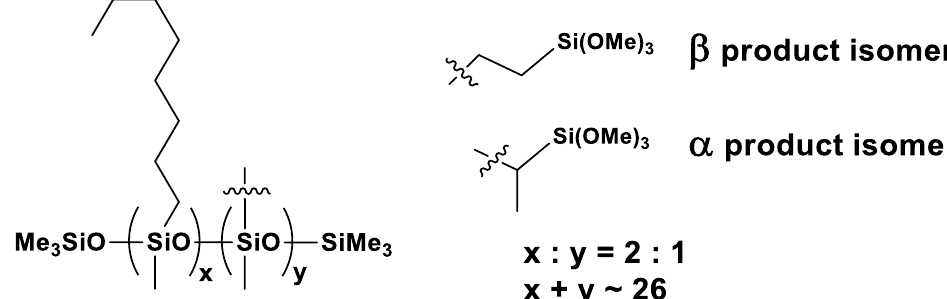
Figure4. Trimethylsilyl-terminatedpoly((methyloctylsiloxane)-co-(methyl)(trimethoxysilyl)ethyl)siloxane)) Figure 4. Trimethylsilyl-terminated poly((methyloctylsiloxane)-co-(methyl)(trimethoxysilyl)ethyl)siloxane)) (SILOX2). (SILOX2).